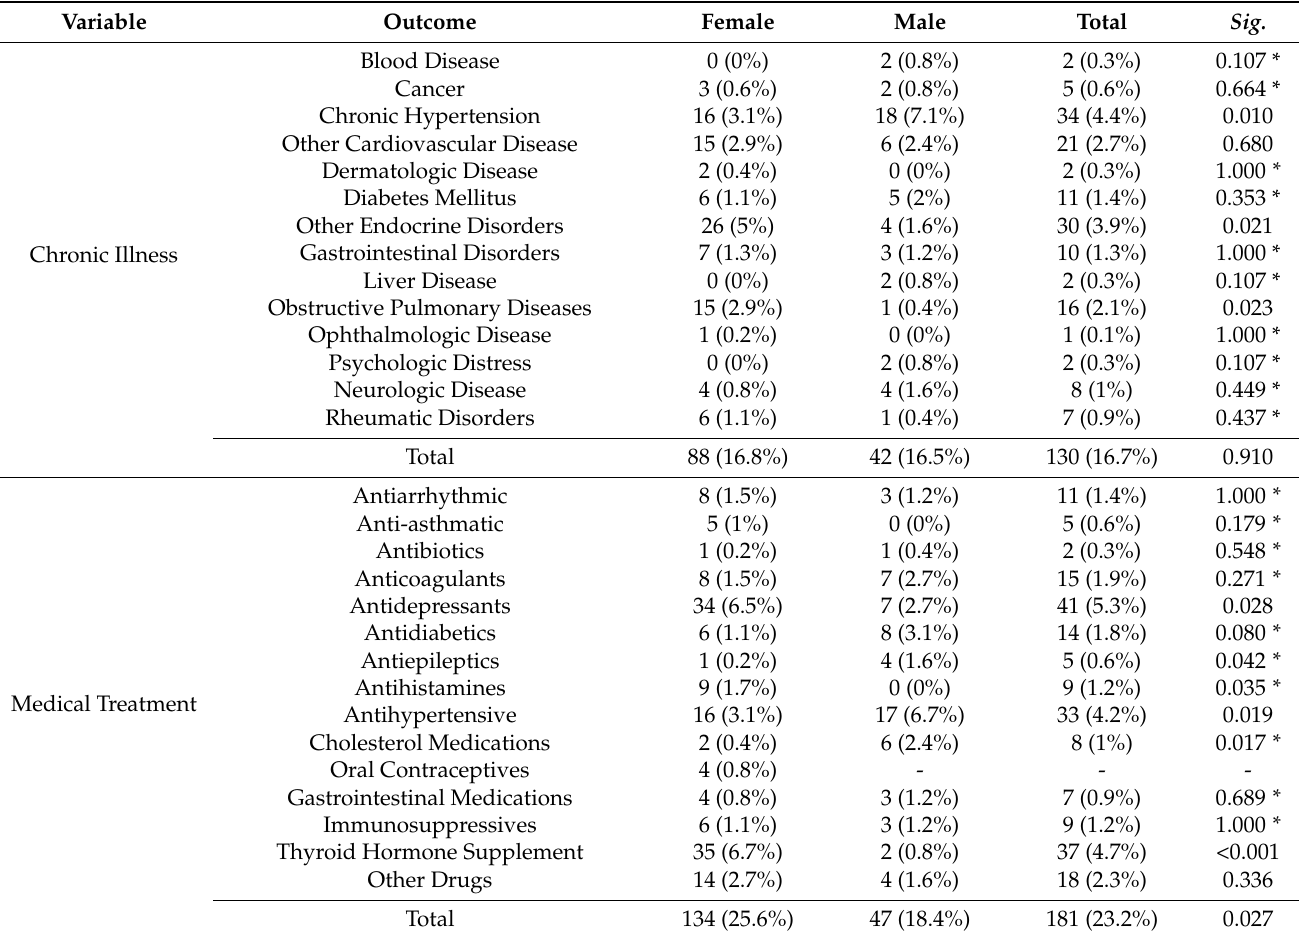
Table 2. Medical anamneses of Turkish healthcare workers vaccinated by CoronaVac, from January–February 2021.